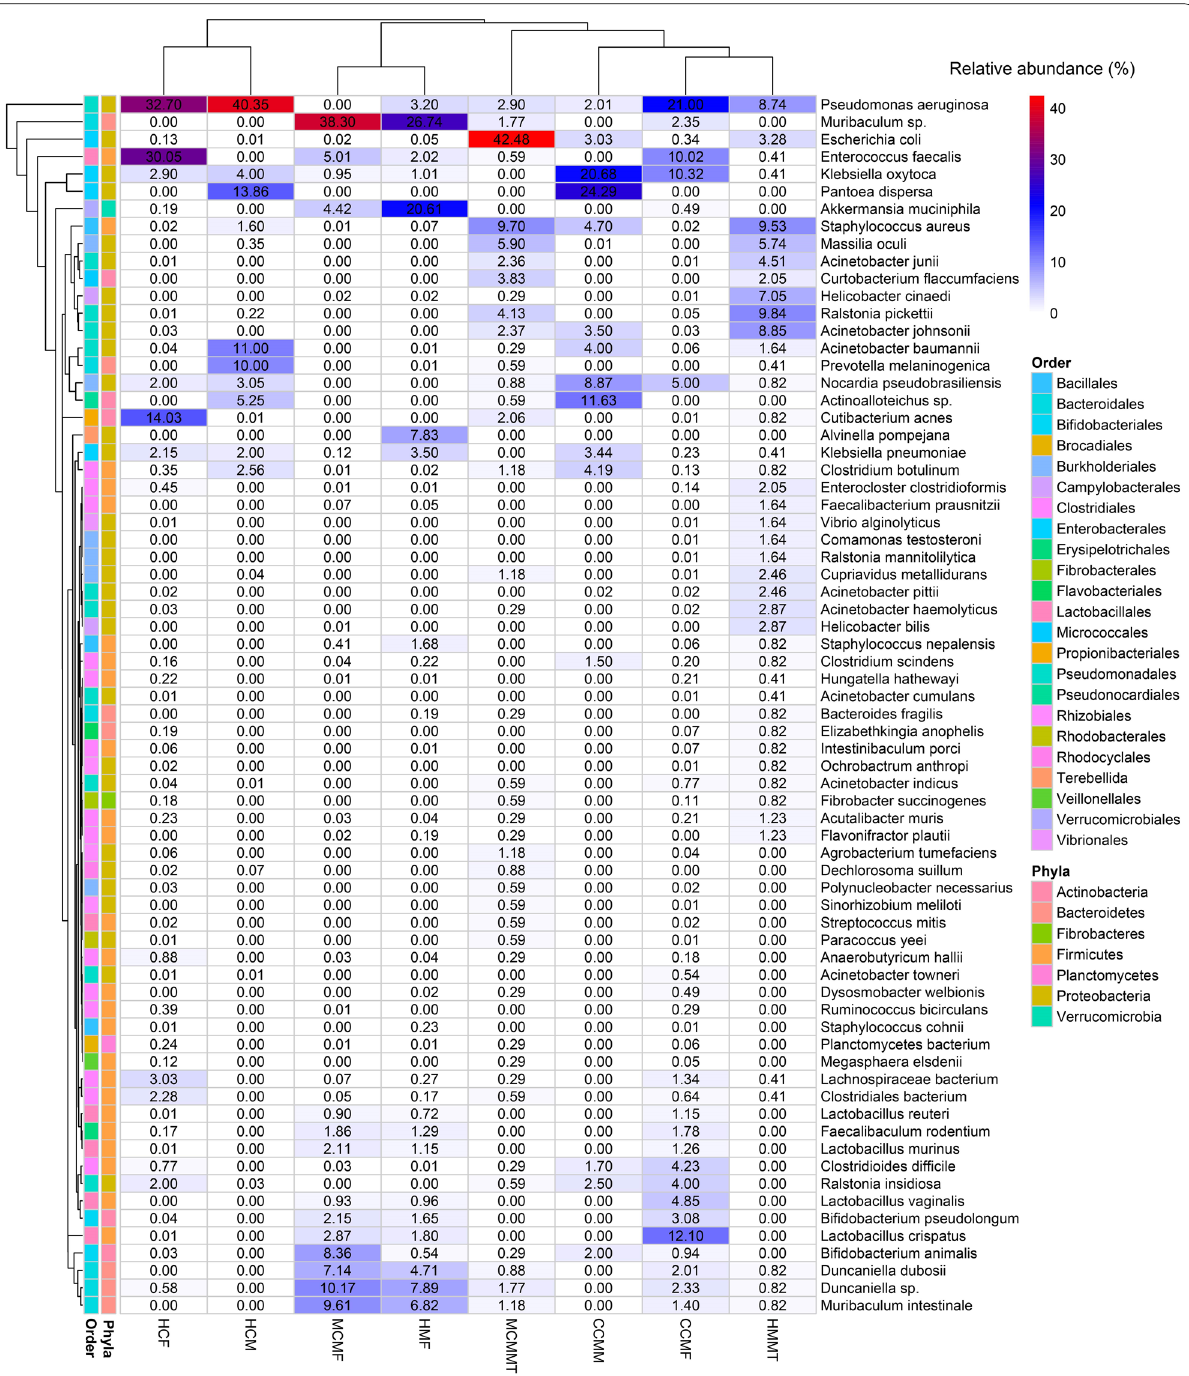
Fig. 4 Species-level taxonomic clustering of bacteria. The heatmap shows the hierarchical clustering of sample groups based on the relative abundance of the top ranked 70 bacterial species identified in cow and mouse mastitis (CCMM, CCMF, MCMF, MCMMT) and healthy (HCM, HCF, HMF, HMMT) metagenomes. The relative values in the heatmap (after normalization), depicted by colors, indicate the aggregation degree or content of bacterial species among samples at the phylum and order level. The color bar (light blue to red) displays the row Z-scores (0–40): red color indicates high abundance, light blue color low abundance. The color of the squares on the left indicates the relative abundance of the bacterial species in each group. The distribution and relative abundance of the bacterial species in the study metagenomes are also available in Additional file